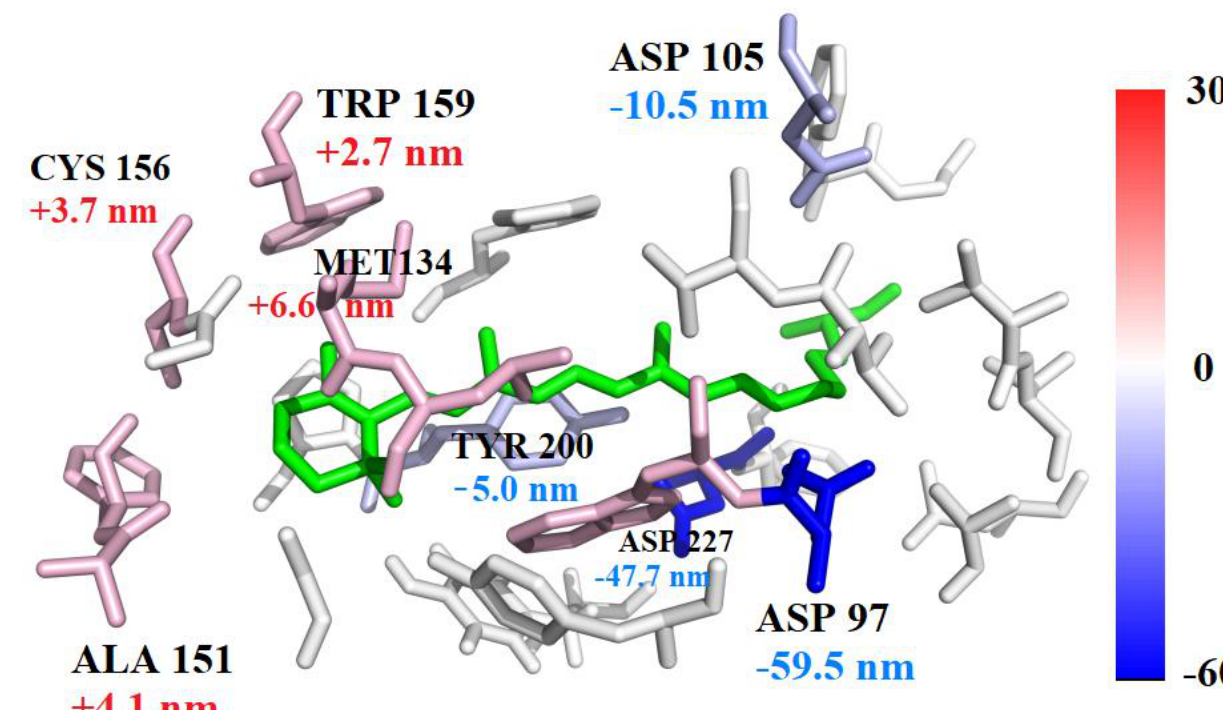
Figure 6. Excitation energy contributions of 2B QM interactions involving residues close to chromophore are presented by the colors blue and red, where the color gradient in units of nm is scaled based on the 2B QM contribution, and the distance threshold λ for 2B correction was set to 4 Å. Residues with positive 2B QM correction have a blue shift of the absorption spectrum and are colored blue, whereas residues with negative 2B QM correction have a red shift and are colored red.